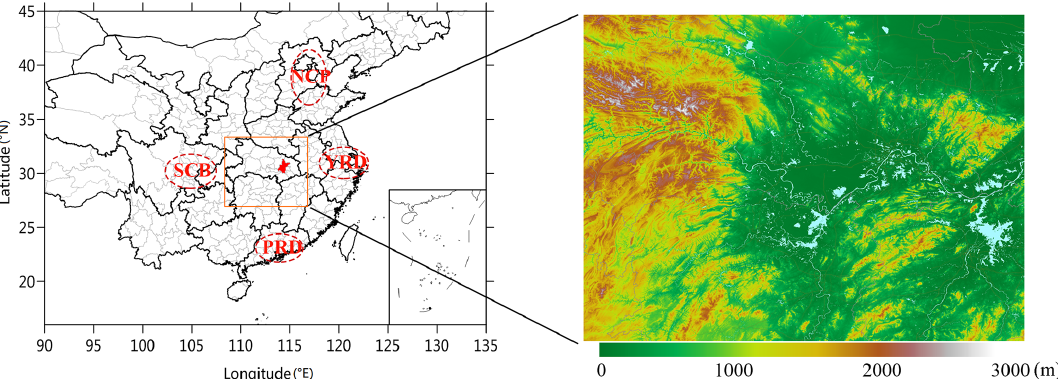
Figure 1. (a) Distribution of the YRMB (orange rectangle) with the location of Wuhan (red area) and the major haze pollution regions of NCP, YRD, PRD, and SCB in CEC as well as (b) the YRMB region with terrain height (color contours, m in a.s.l.). The river and lake network (blue areas) are downloaded from https://worldview.earthdata.nasa.gov (last access: 13 June